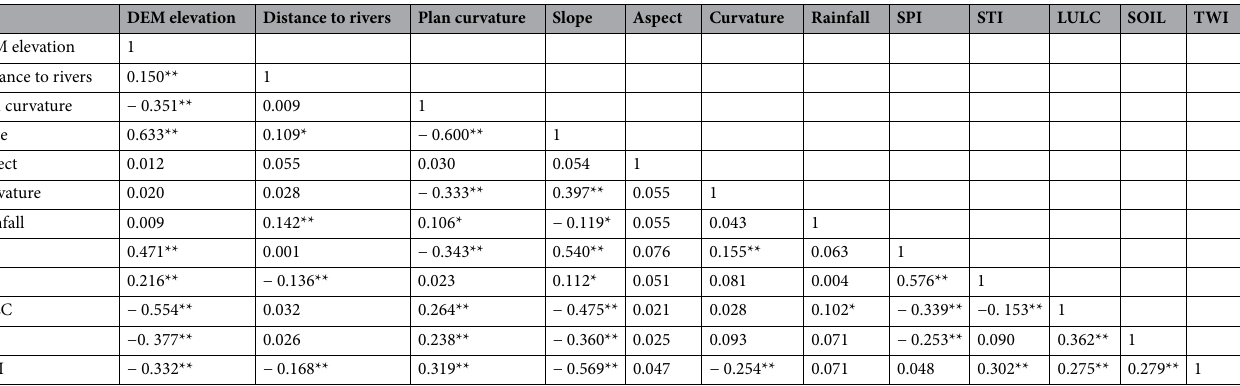
Table 3. Pearson’s correlation matrix. **Correlation is significant at the 0.01 level (2-tailed). *Correlation is significant at the 0.05 level (2-tailed).